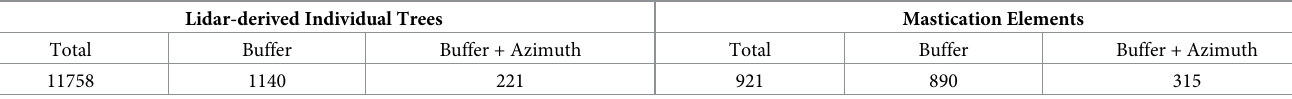
Table 5. Machine and individual stem location matching. This table displays the number of lidar-derived individual trees based on the ForestView ™ software: within the overall treatment units; within the 7m treatment buffer of the machine cab during mastication elements; and within the cab buffer while corresponding with the machine orientation. The total number of mastication elements and the number of elements where an individual tree fell within the machine buffer and matched the machine orien- tation are also shown. Lidar-derived Individual